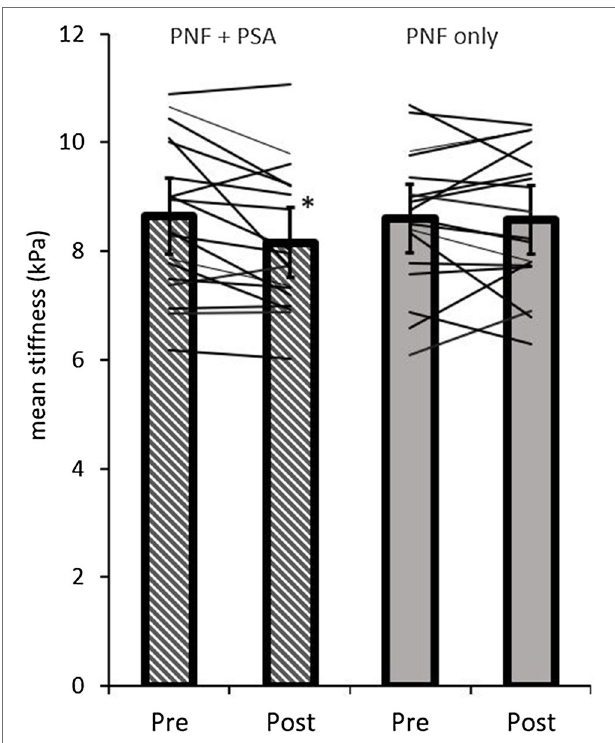
FIGURE 5 | Pre- and post-mean shear modulus values of both groups (PNF only and PNF + PSA) and the individual changes. * = significant change between pre- and